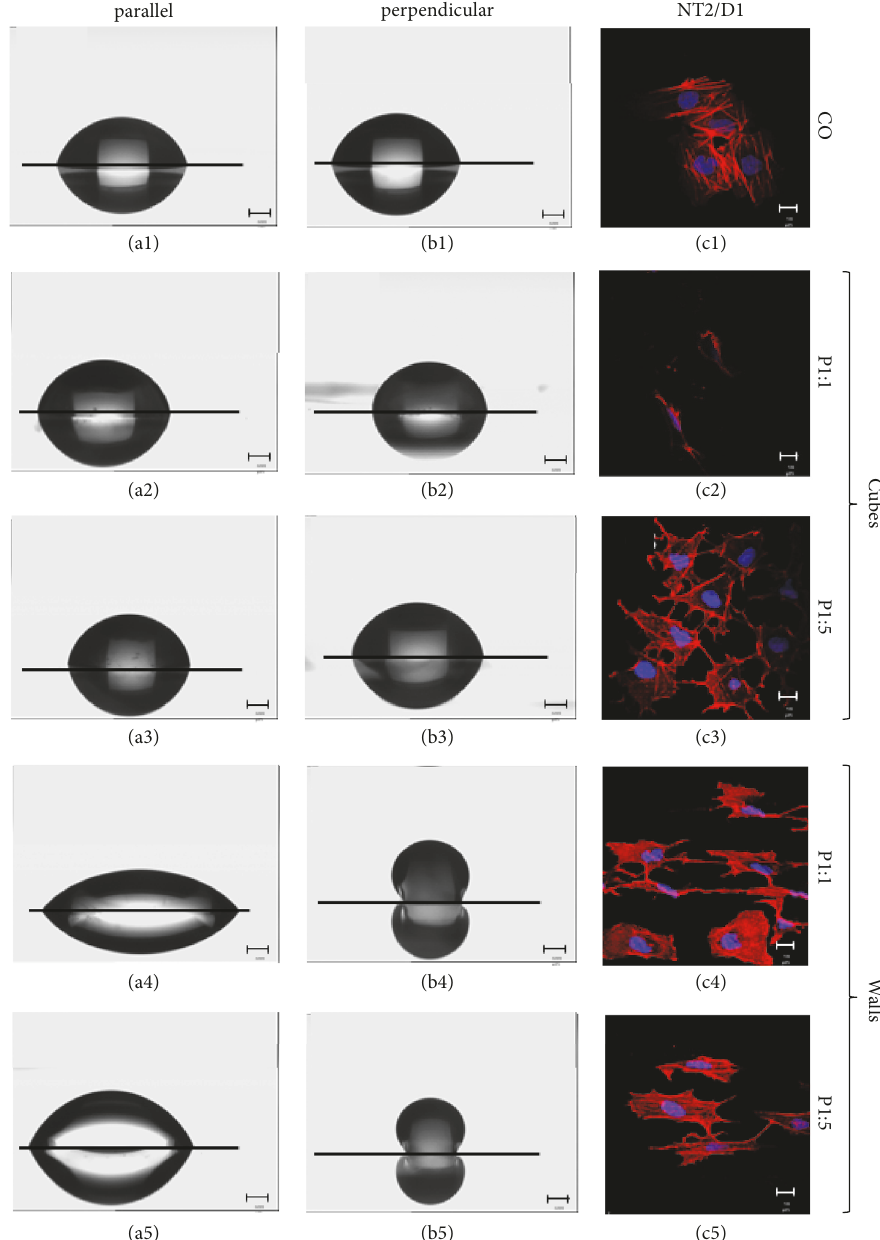
Figure 5: The water drop model. Comparison between water droplet shapes and cell morphology of NT2/D1. (a1)-(a5): side view, parallel to walls reference; (b1)-(b5): side view, perpendicular to walls reference; (c1)-(c5): NT2/D1 cells in LSM top view on microstructures. Microstructures indicated on the right side. Scale bar=10 𝜇